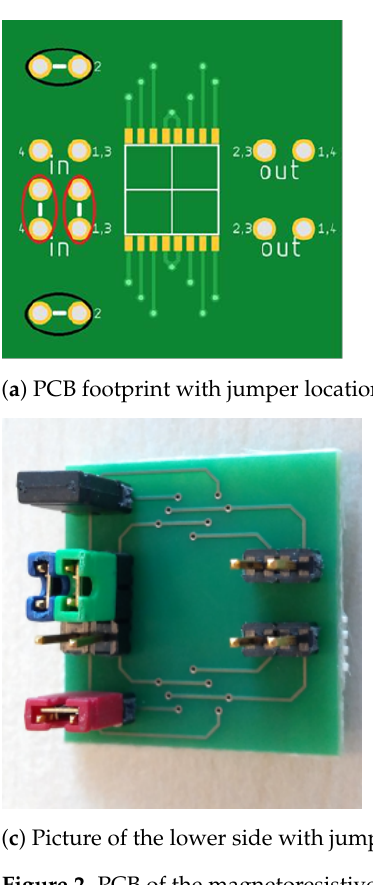
Figure 2. PCB of the magnetoresistive